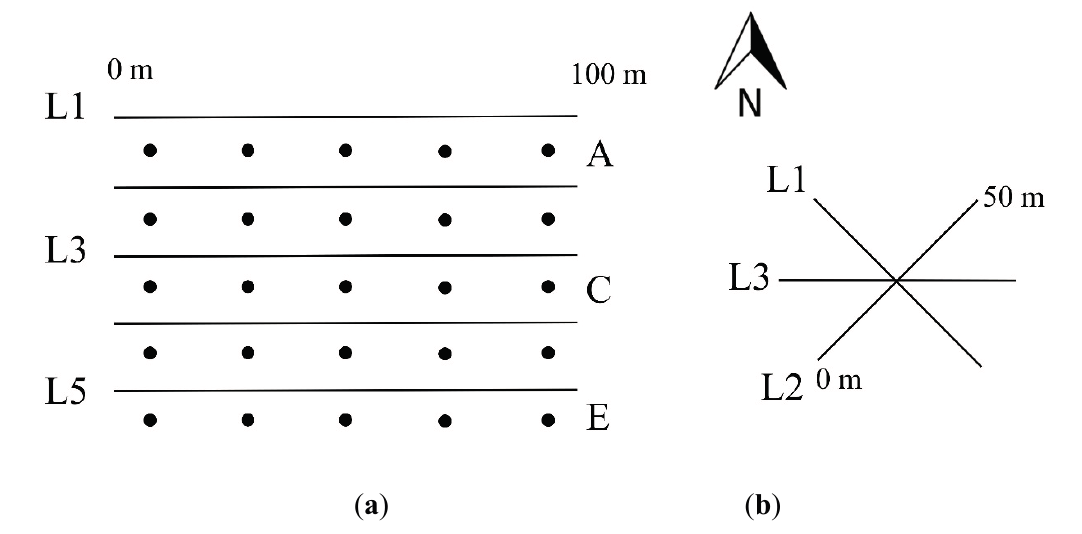
Figure 2. ( a ) TRAC-DHP 100-m quadrant. Five 100-m TRAC lines separated by 20 m. DHP sample points interspersed 20-m apart between TRAC lines. ( b ) Sub-plots with three TRAC lines (50 m and 100 m) at 45°, 90°and 225°